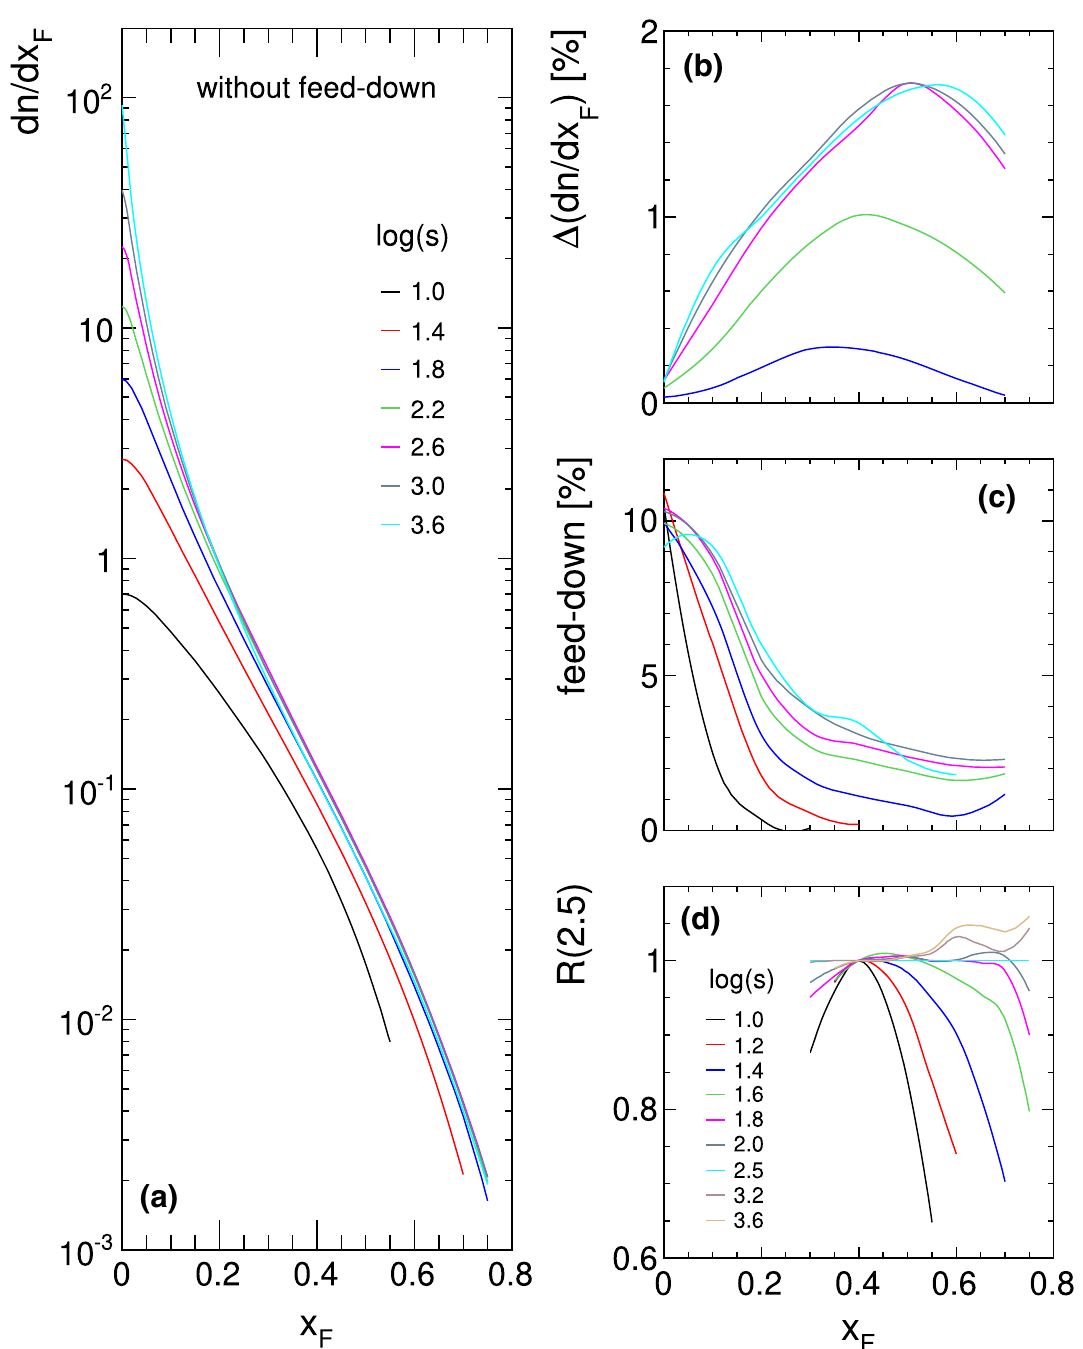
Fig. 146 a dn / dx F distributions as function of x F for several log ( s ) values from 1 to 3.6 using the p T integration up to 1.3 GeV/c, b percent increase of dn / dx F extending the p T range from 1.3 to 1.9 GeV/c,